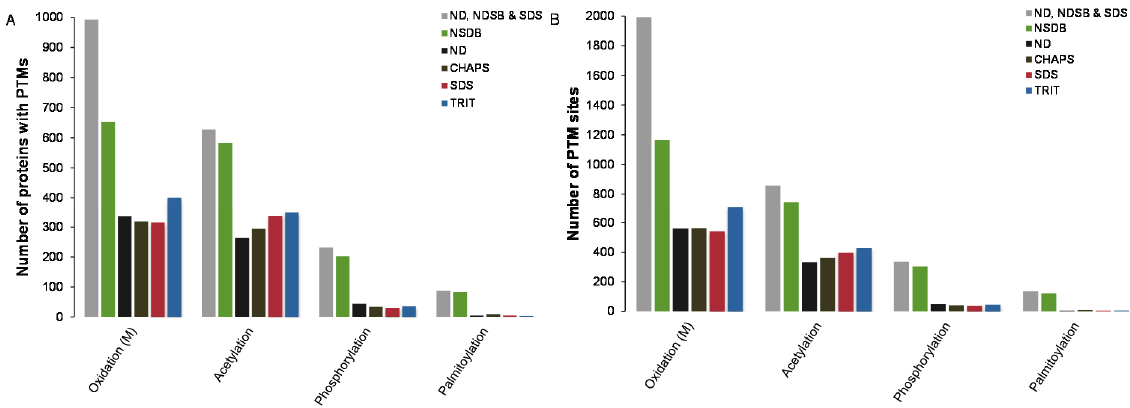
Figure 4. Number of predicted ( A ) post-translation modifications (PTMs) and ( B ) sites for individual buffer systems and the two-step solubilization process. During protein identification in the MASCOT and Scaffold, acetylation, oxidation, phosphorylation and palmitoylation were set as variable modifications. Bars represent the ( A ) number of proteins and ( B ) PTM sites that contain the PTM of